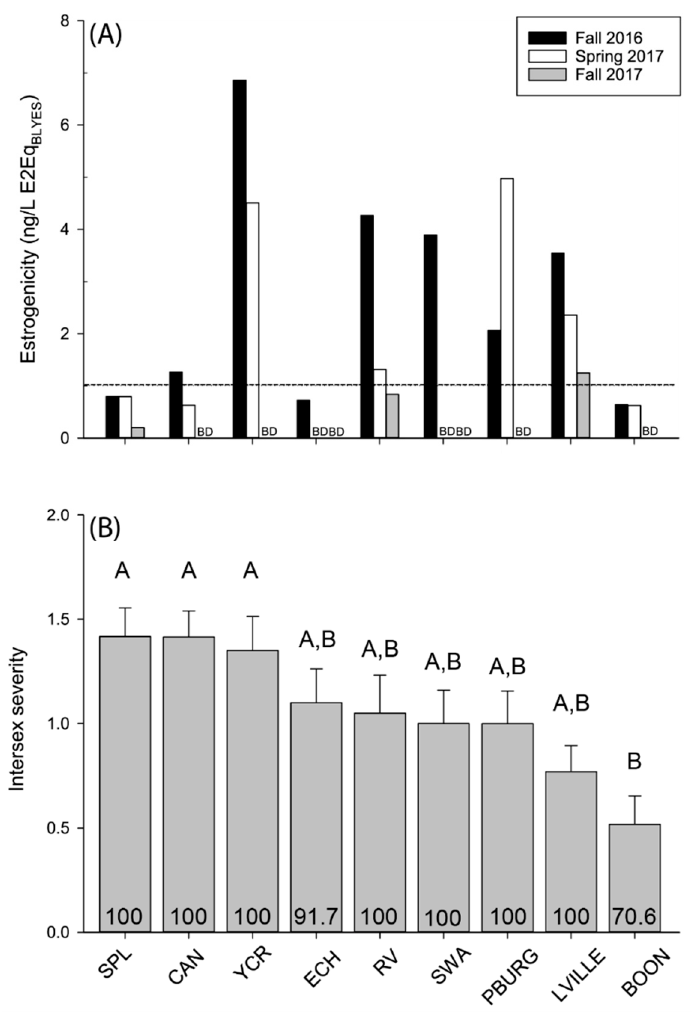
Figure 2. (A) Seasonal variation in EEQ BLYES at the fish collection sites. (B) Intersex severity in male smallmouth bass collected from New Jersey during the spring of 2017. Intersex prevalence (%) is indicated at the base of each vertical bar. Error bars denote standard error of the mean. Statistical differences in intersex severity are indicated above vertical bars. Bars denoted with different letters indicate statistically significant di ff erences ( α = 0.05). Site abbreviations are defined in Table 1. Dotted line indicates the USEPA e ff ects-based trigger value (EBT) of 1 ng / L E2Eq. BD indicates values below detection.